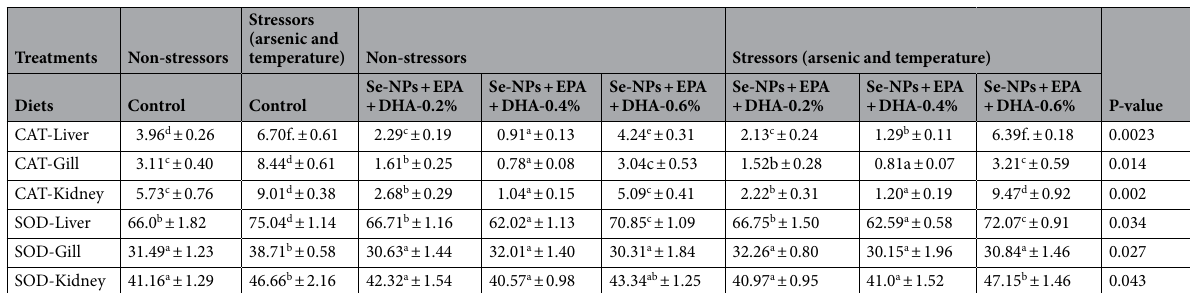
Table 3. Mitigation of secondary stress response (catalase and superoxide dismutase) through dietary supplementation of selenium nanoparticles, eicosapentanoic acid and dicosahexanoic acid fed to P. hypophthalmus reared in control or under arsenic and high temperature for 105 days. Values in the same row with different superscript (a, b, c, d, e, f) differ significantly. Data expressed as Mean ± SE (n = 6). Catalase and SOD: Units/mg